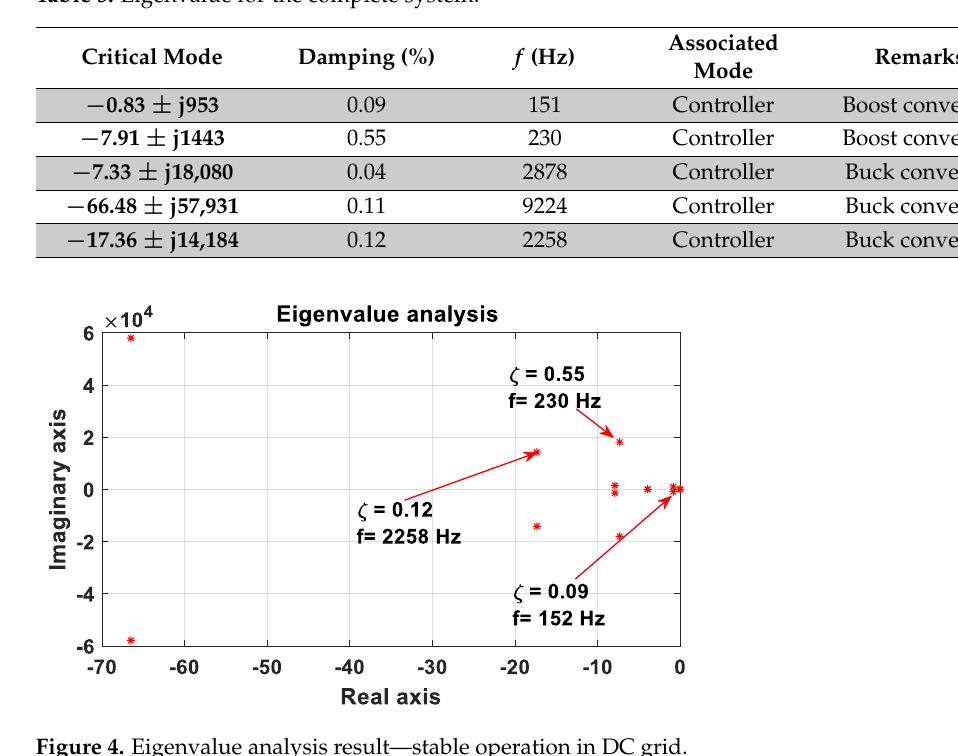
Table 5. Eigenvalue for the complete system.